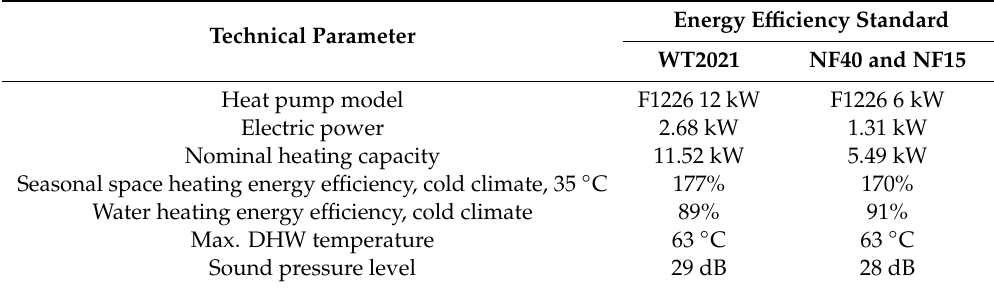
Table 8. Basic technical parameters of the ground source heat pump (GSHP) selected for the WT2021, NF40 and NF15 standards